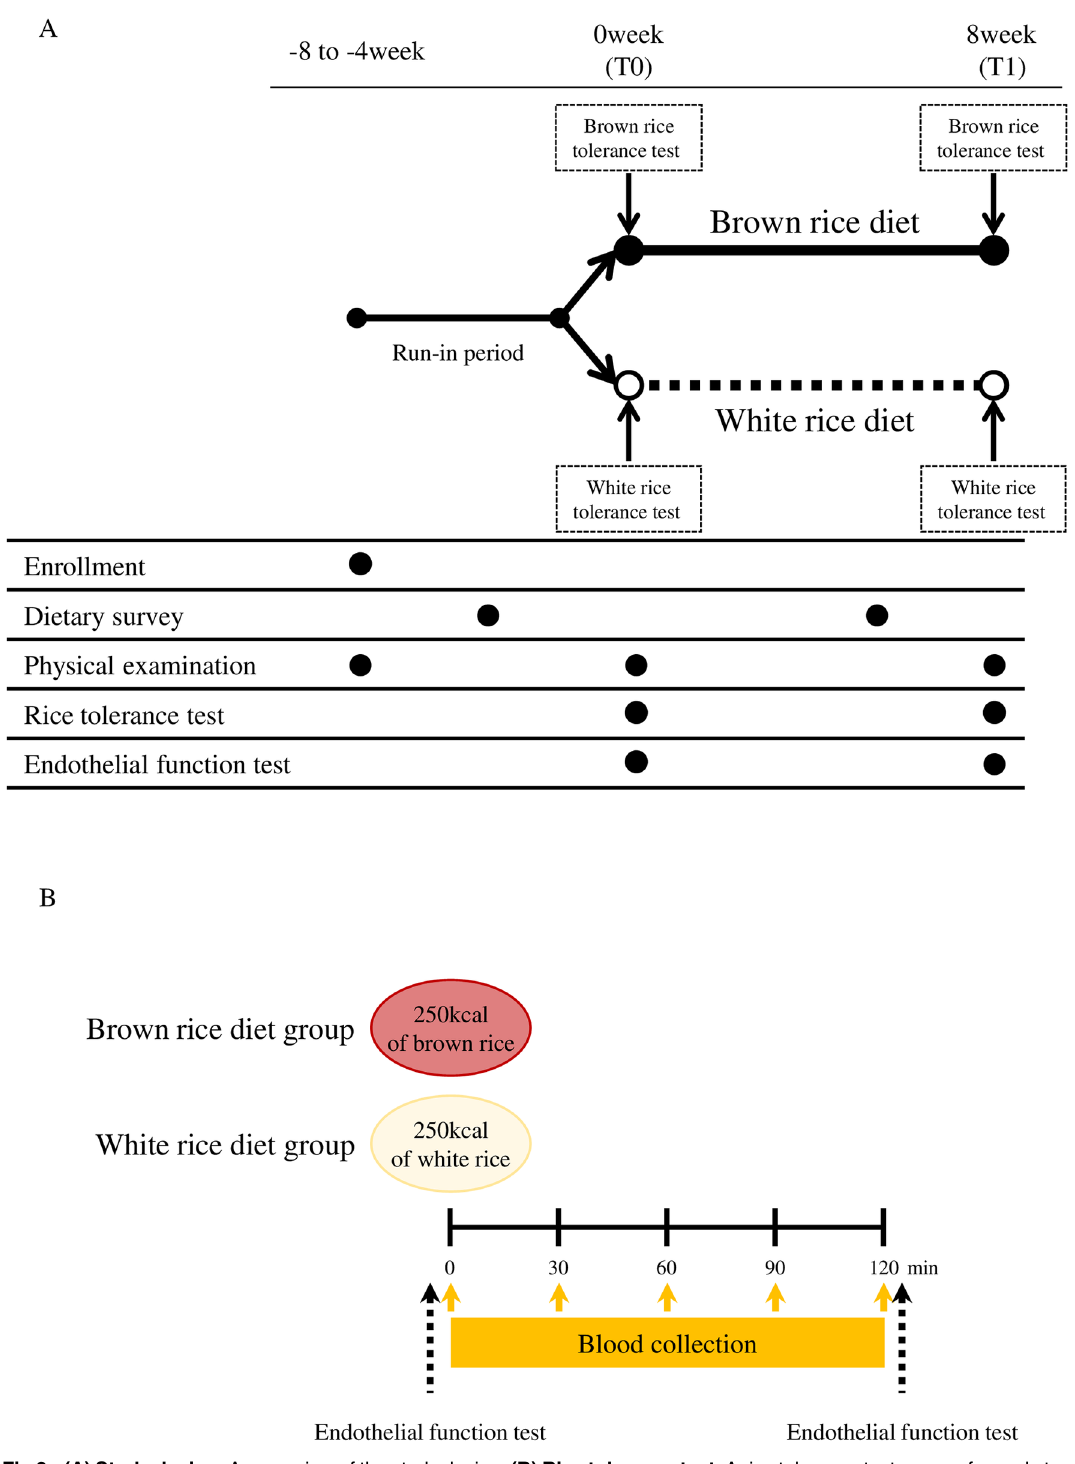
Fig 2. (A) Study design . An overviewof the study design. (B) Rice tolerance test . A rice tolerancetest was performed at baseline(T0) and at the end of intervention (T1). The participants in each group ingested an isocaloric (250 kcal) amount of assignedrice. Blood collectionswere performed at fasting, 30, 60, 90, and 120 min after assignedrice ingestion.Endothelial function tests were performed at fasting and 120 min after assignedrice ingestion.